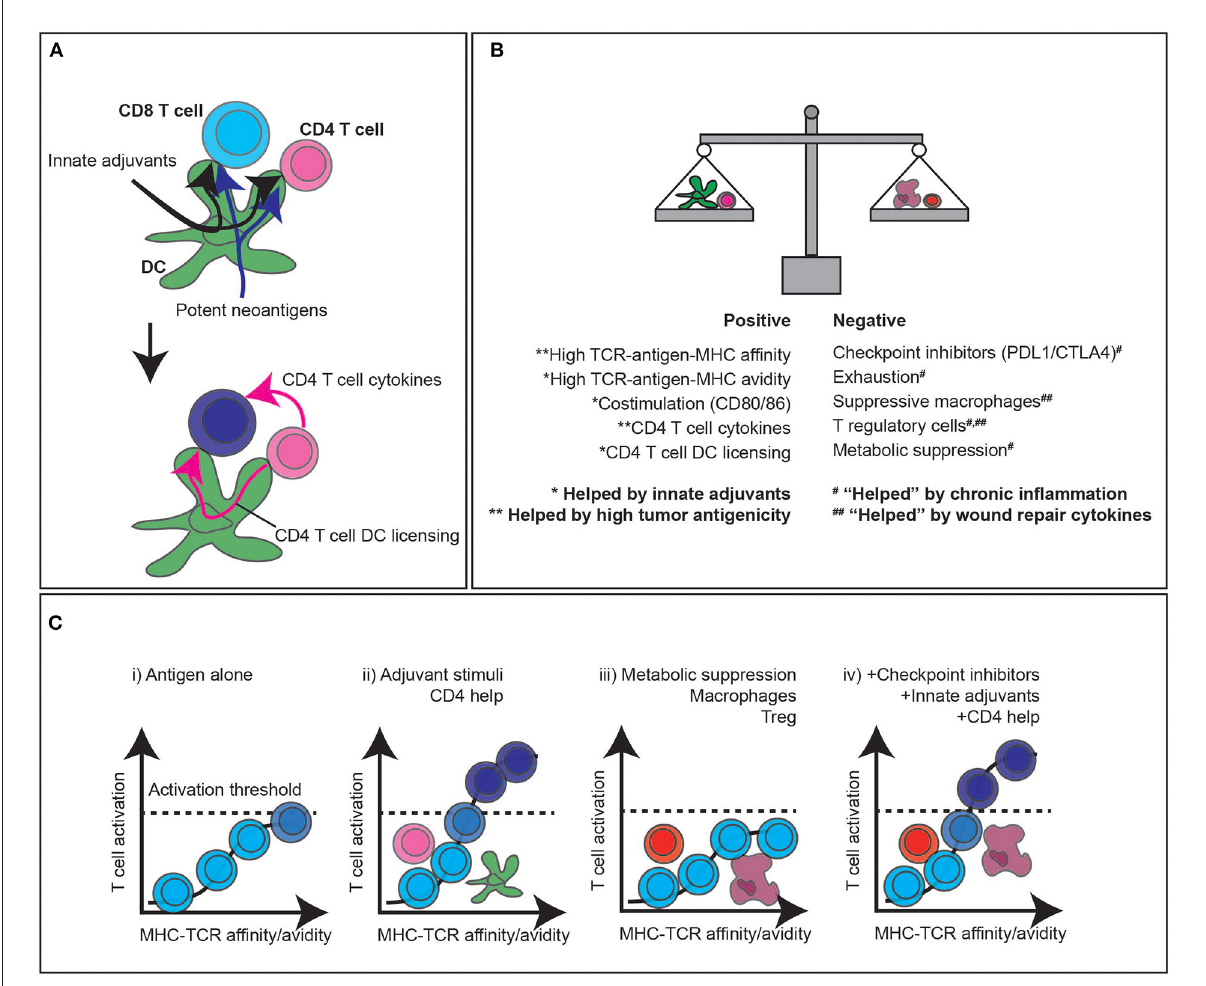
FIGURE3 CD4T cell help, adjuvant signals, and immunotherapy to enhance CD8T cell responses to tumors. (A) The classic three cell model of CD8T cell activation relies on antigens being presented to both CD4 and CD8T cells by dendritic cells. Innate adjuvants present in the infection improve antigen processing and presentation, as well as upregulate costimulatory molecules. Highly antigenic targets increase the likelihood of high affinity antigens being available for both CD8 targeting and CD4T cell help. (B) The balance of positive and negative stimuli dictate whether T cells can contribute to anti-tumor responses. Broadly, highly antigenic tumors with endogenous adjuvant support can improve the likelihood of T cell responses, which are countered by a range of negative regulatory features of the tumor environment. (C) High affinity antigen-specific T cell responses have the potential to stimulate T cells independently, but the likelihood of passing the critical activation thresholds is increased by CD4 help and adjuvant signals to cross-presenting DC and directly presenting cancer cells. A range of suppressive factors in the tumor can decrease the ability of T cells to pass the critical activation threshold to control tumors, and current immunotherapies can overcome these limitations to overcome suppression and bring new T cells into the response that were formerly unable to cross the activation threshold to participate in tumor